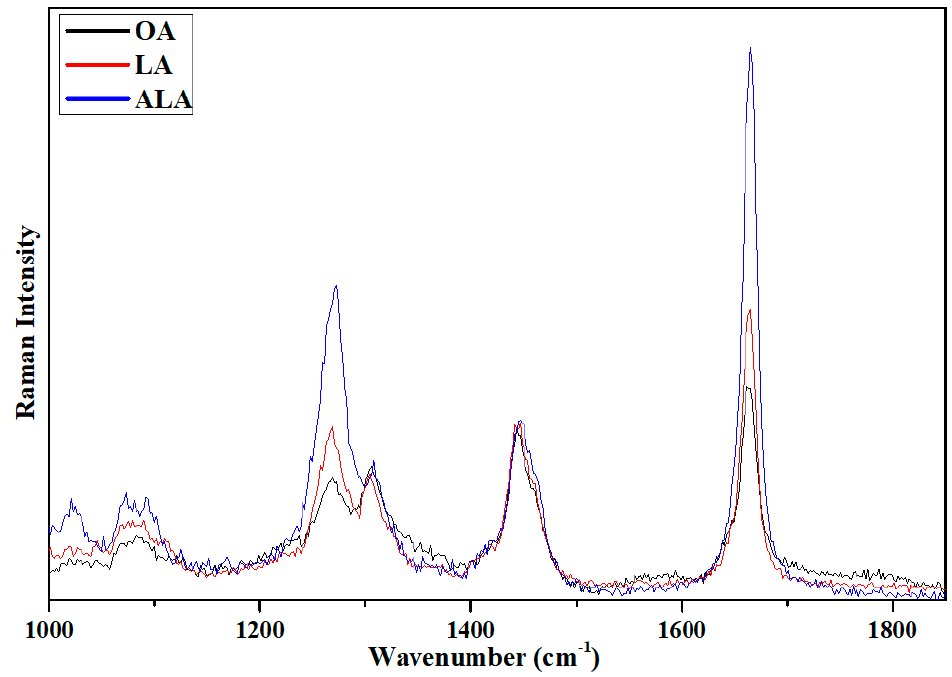
Figure 5. Raman scattering spectra of oleic acid (OA), linoleic acid (LA), and α -linolenic acid (ALA). The intensity was normalized using the intensity of the band at 1440 cm − 1 as a